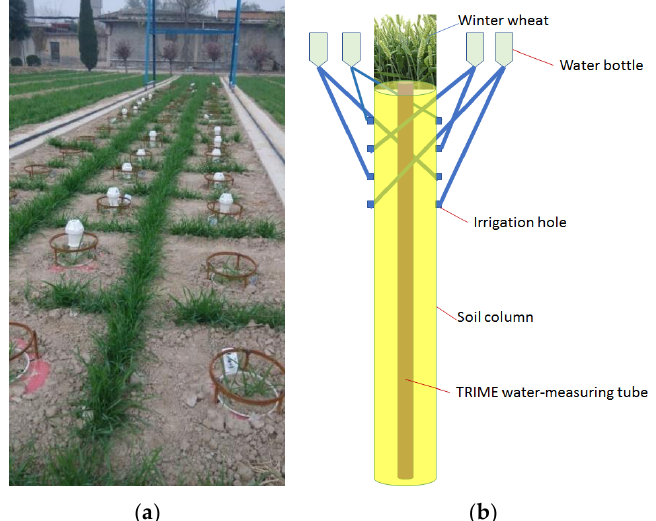
Figure 1. The schematic diagram of the test layout. ( a ) Field layout; ( b ) Test equipment. TRIME refers to the time domain reflectometry with intelligent microElements.